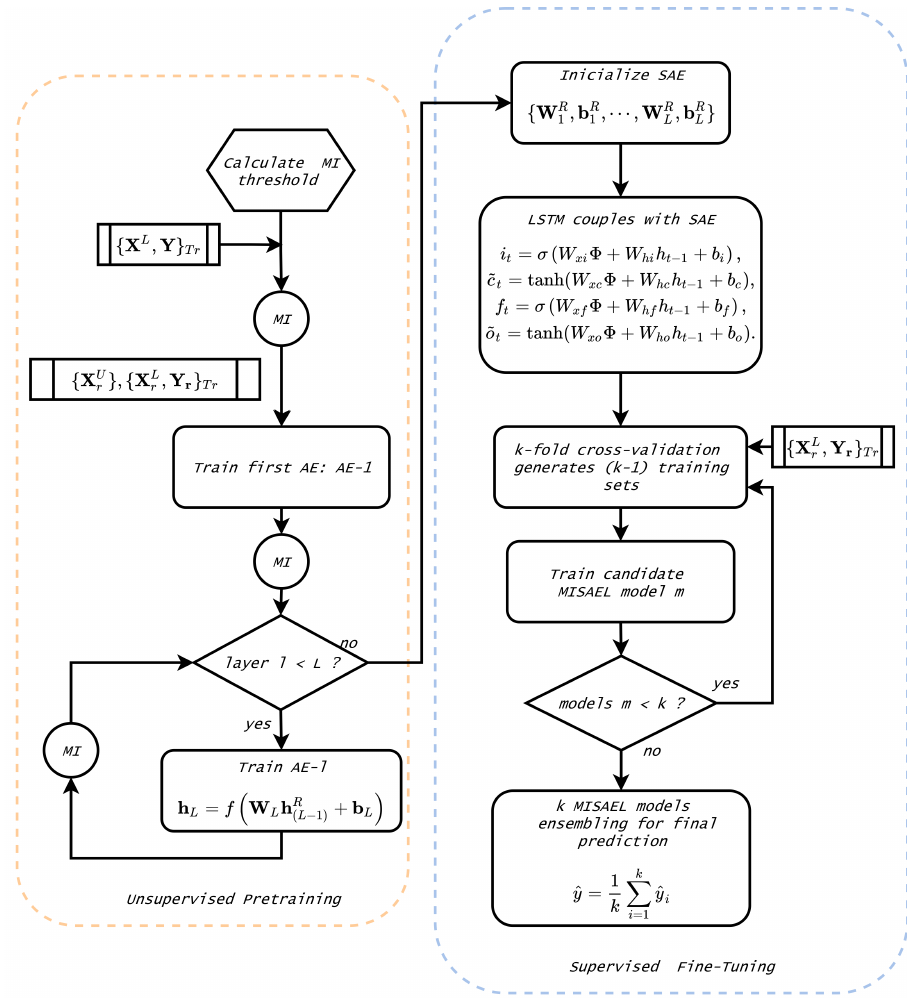
Figure 5. Proposed MISAEL method